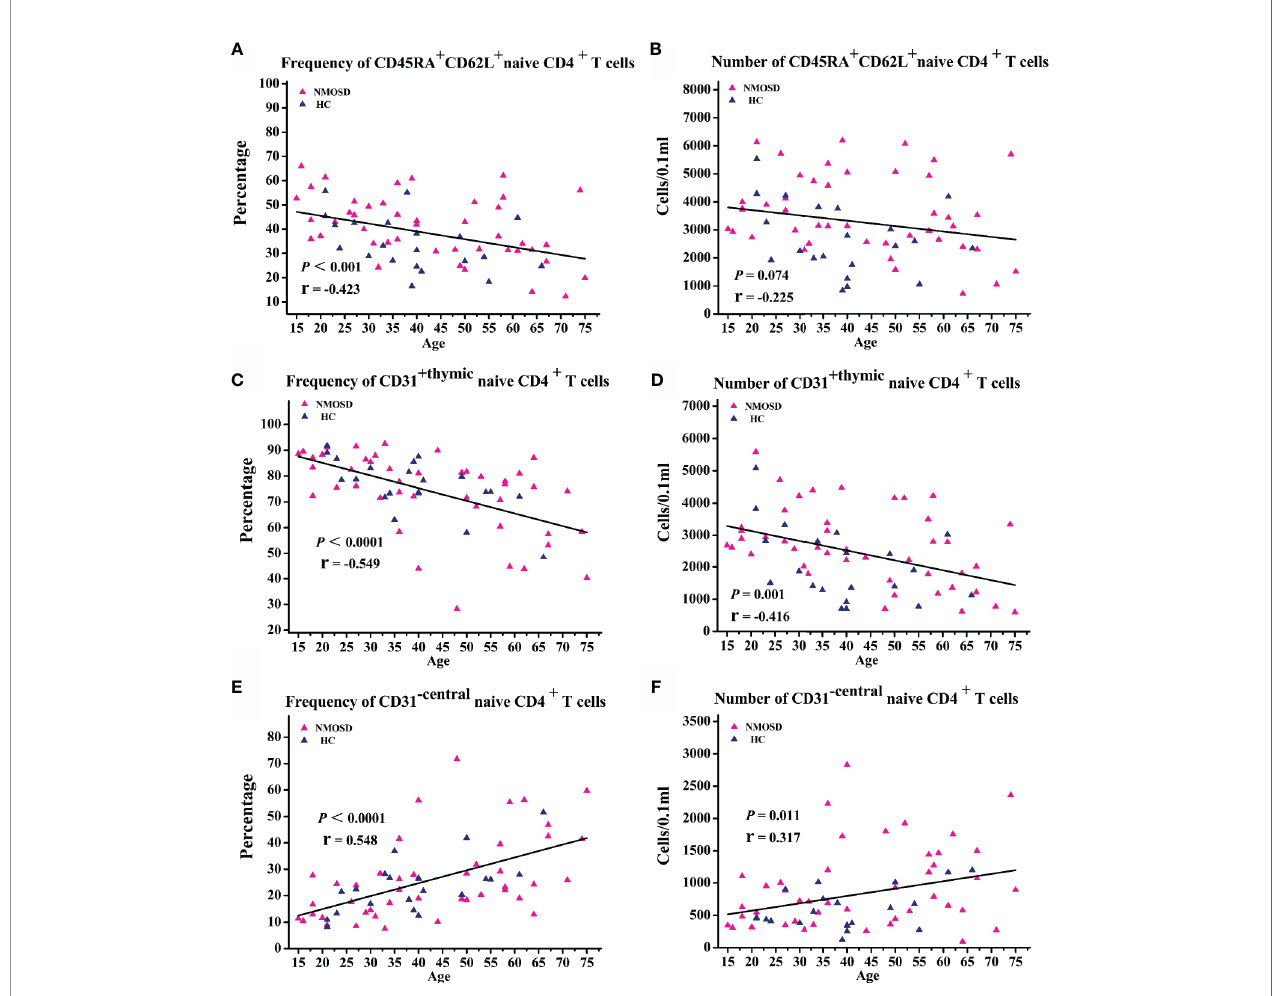
FIGURE 2 | Correlation analysis of naive T cell subpopulations with age. (A – F) Scatter plots showing the correlation of naive T cell subpopulations with age. NMOSD, Neuromyelitis optica spectrum disorder; HC, healthy